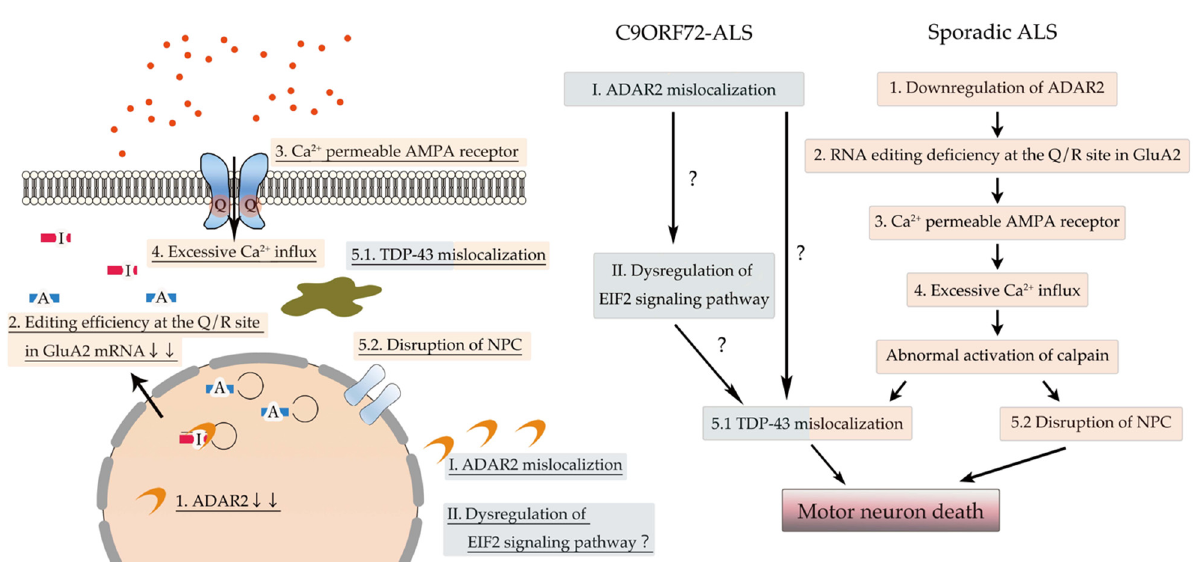
Figure 3. ADAR2-GluA2 hypothesis: specific molecular abnormalities beginning with a reduction in ADAR2 activity due to downregulation of ADAR2 in sporadic ALS or ADAR2 mislocalization in C9ORF72 ALS. The numbers and arrows indicate the order of molecular cascade based on the hypothesis. Uncertain parts were indicated by question marks.